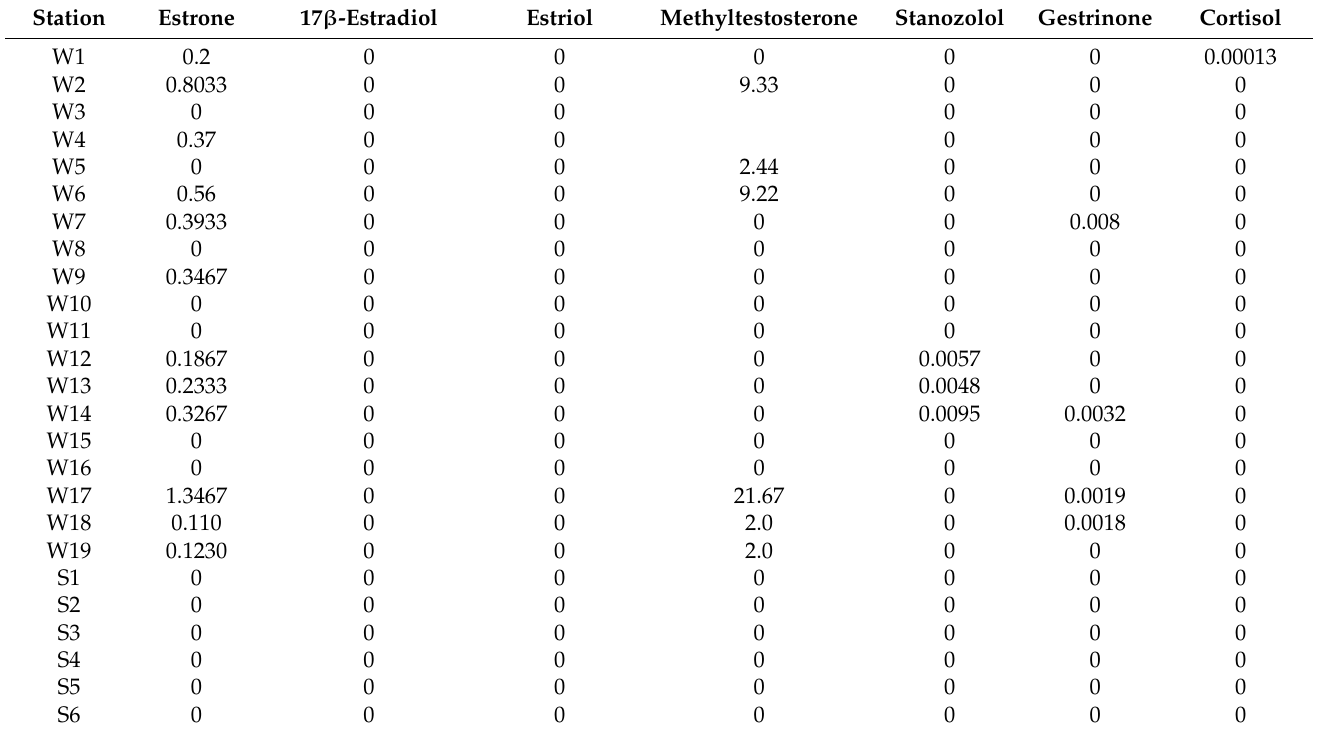
Table 1. RQ value of target steroids in the water